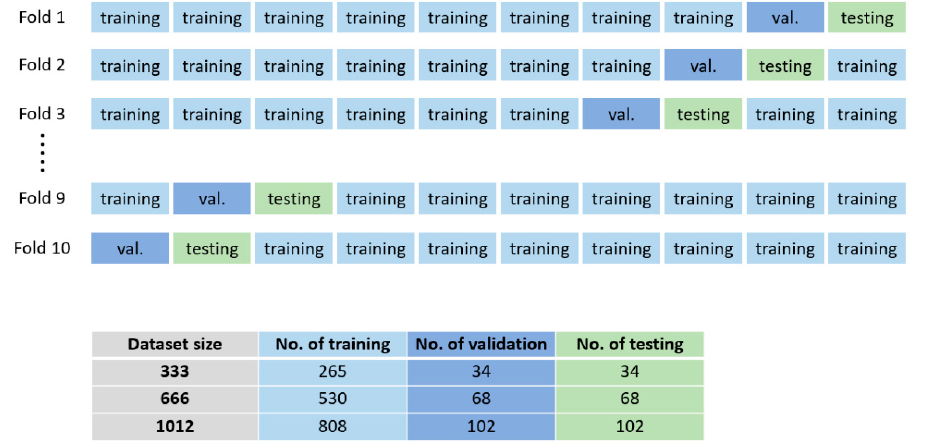
Figure 5. Training domains. A total of 1012 CT studies were collected. To compare the training effects with different dataset sizes, 333 and 666 CT studies were randomly selected from the dataset. Further original and enhanced bone signal conditions were processed into GAN architecture.